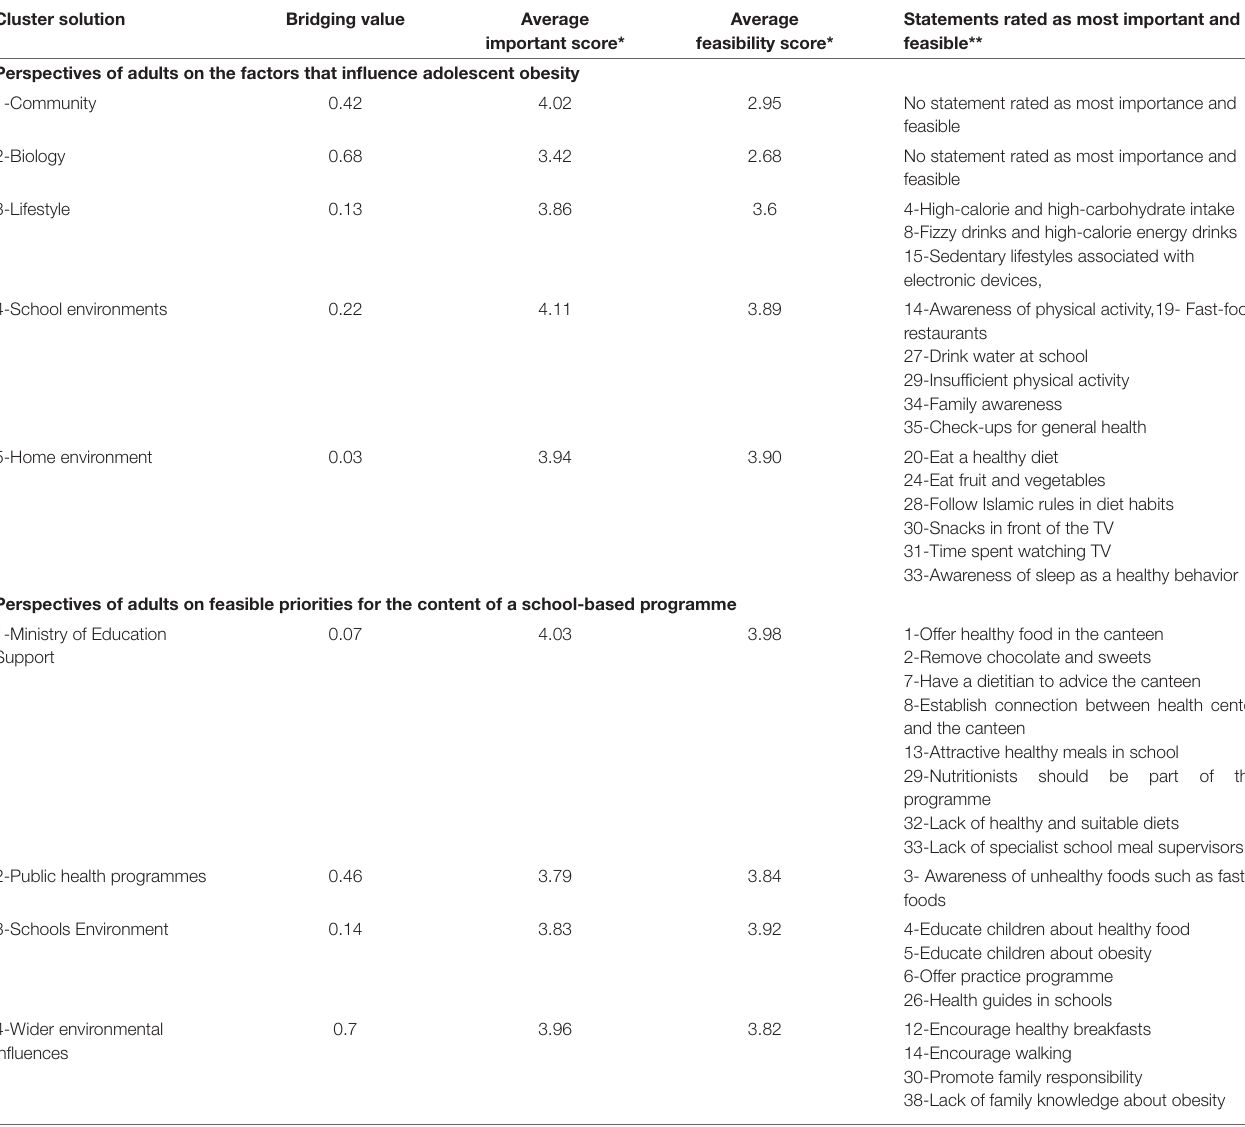
TABLE 2 | Adults’ perspectives on factors that influence adolescent obesity and on feasible priorities for the content of school-based programmes: average bridging values and average ratings for importance and feasibility for each cluster, statements that were rated relatively high for both importance and feasibility (upper right quadrant of the Go-Zone